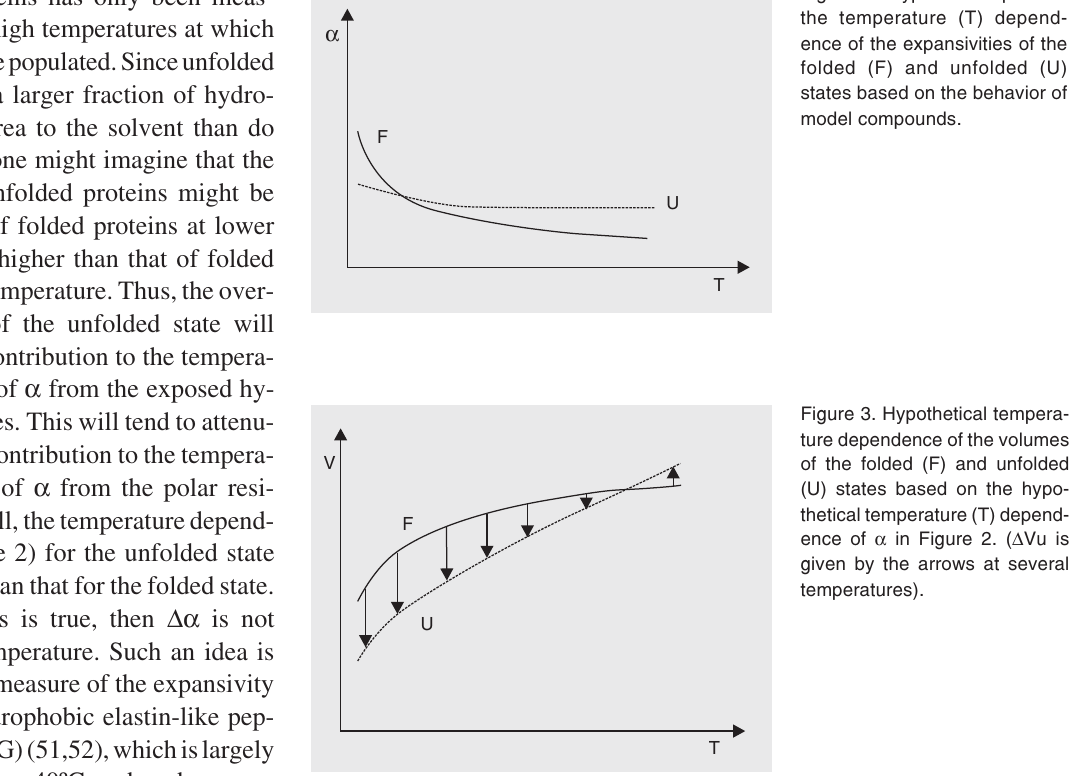
Figure 2. Hypothetical plots of the temperature (T) depend- ence of the expansivities of the folded (F) and unfolded (U) states based on the behavior of model compounds.